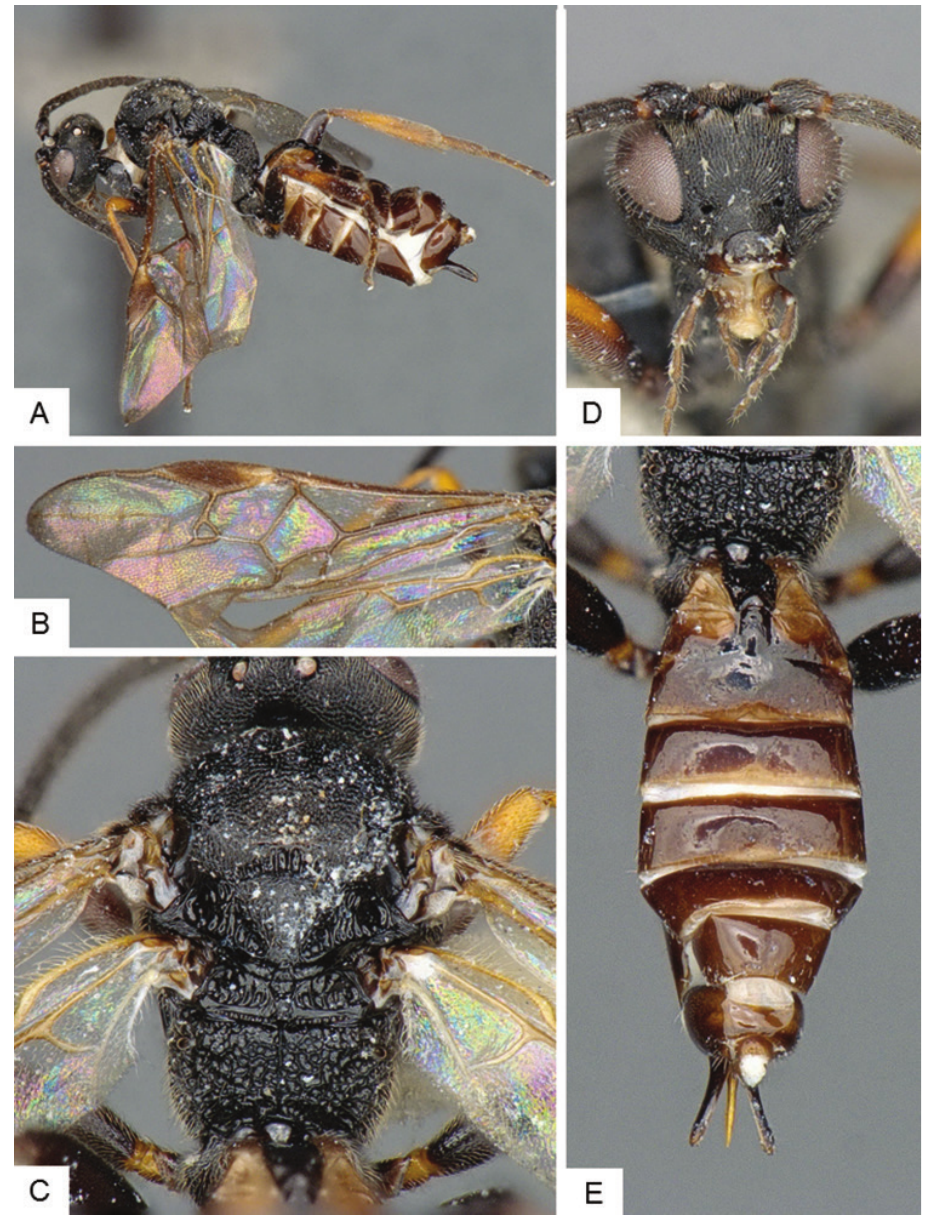
Figure 28. Microplitis lugubris . A Habitus, lateral B Fore wing C Mesosoma, dorsal D Head, frontal E Metasoma,